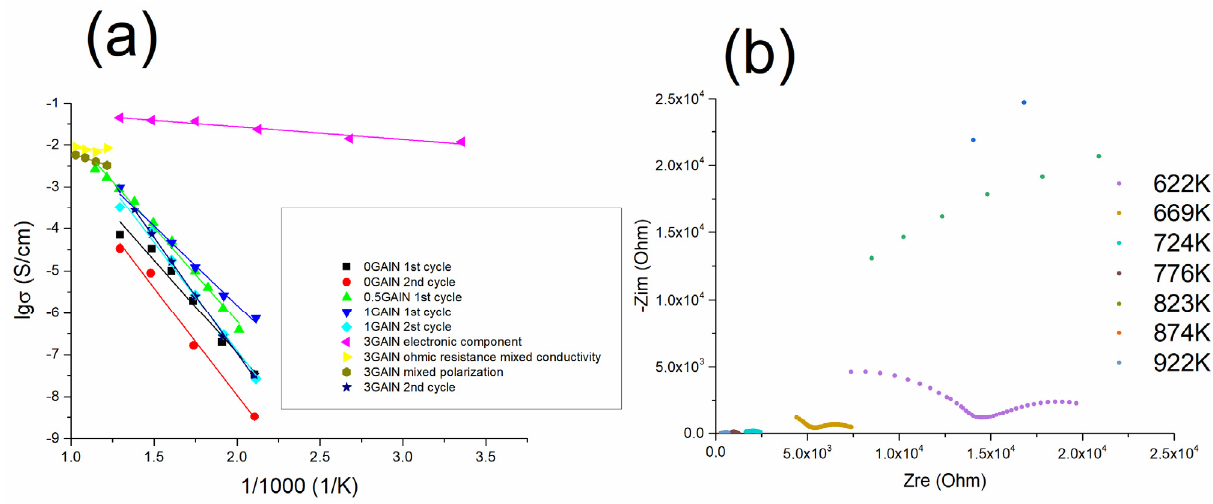
Figure 13. ( a ) Arrhenius plots of total conductivity for samples 0 GAlN–3 GAlN after the first and the second cycles of the thermal treatment; ( b ) the impedance spectra obtained at 622–922 K.